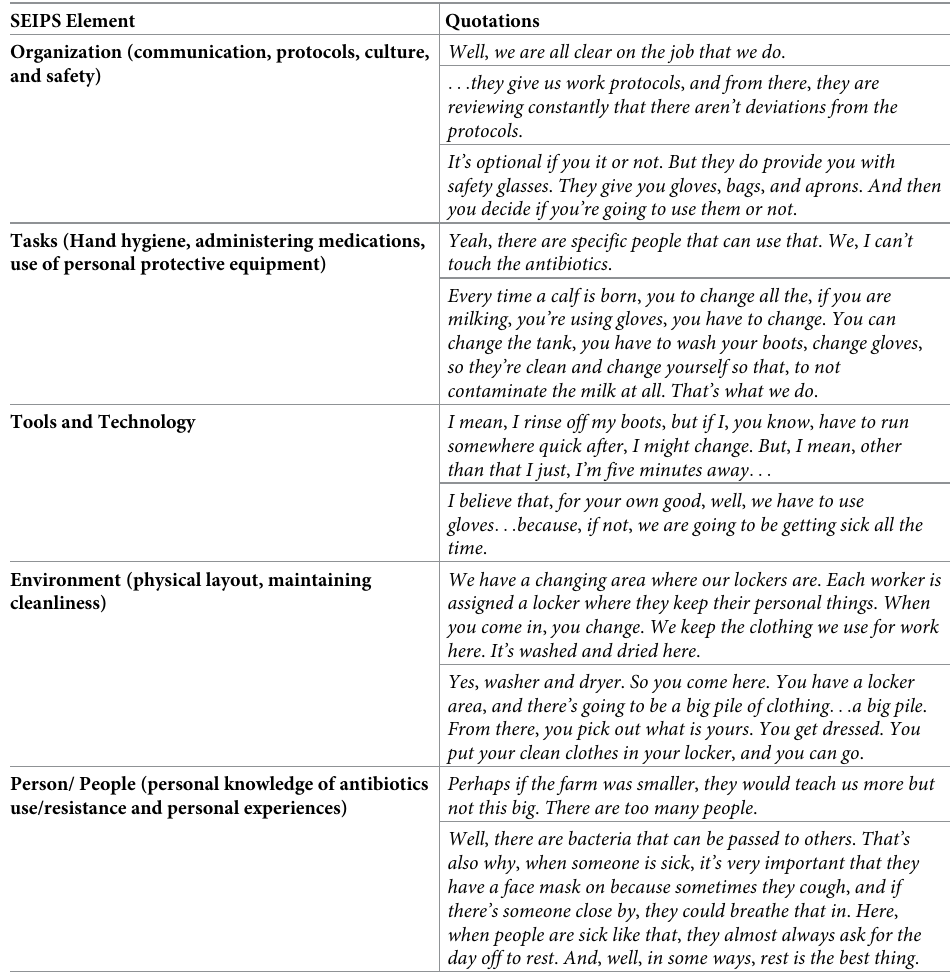
Table 2. Representative quotes associated with each SEIPS